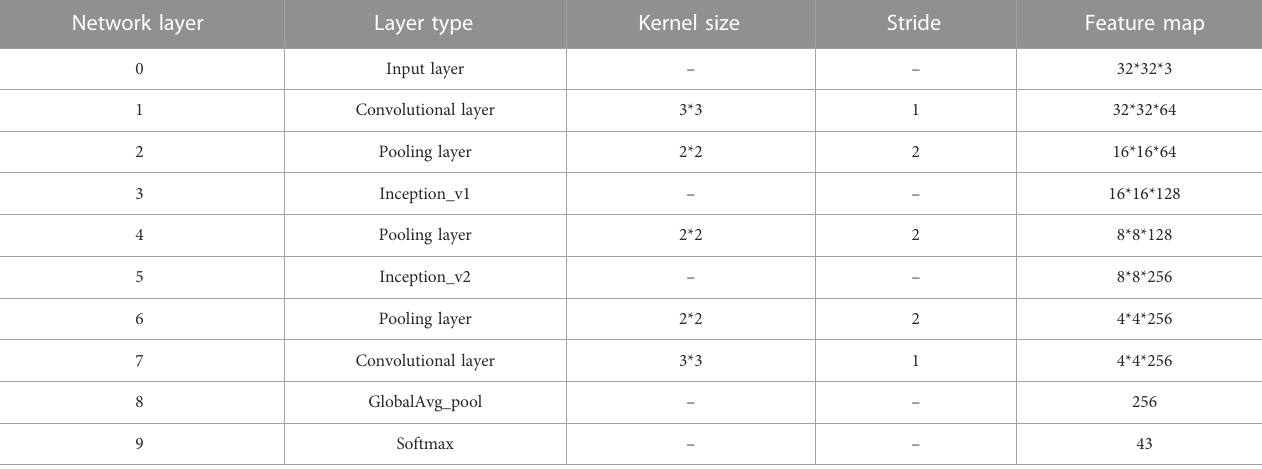
TABLE 2 Improved structure parameters of convolution neural network.